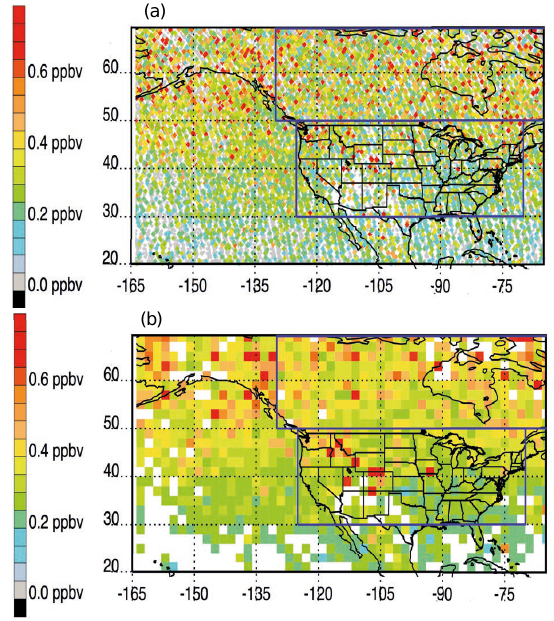
Figure 2. Average tropospheric PAN in retrievals (DOF>0.6) dur- ing July 2006–July 2009 (a) , and those retrievals averaged in a 2 ◦ × 2 ◦ grid (b) . The white areas designate locations with less than five measurements during this period. The blue lines surround the regions included in the calculations in Figs. 4 and 5: 125–70 ◦ W, 30–50 ◦ N and 130–65 ◦ W, 50–70 ◦